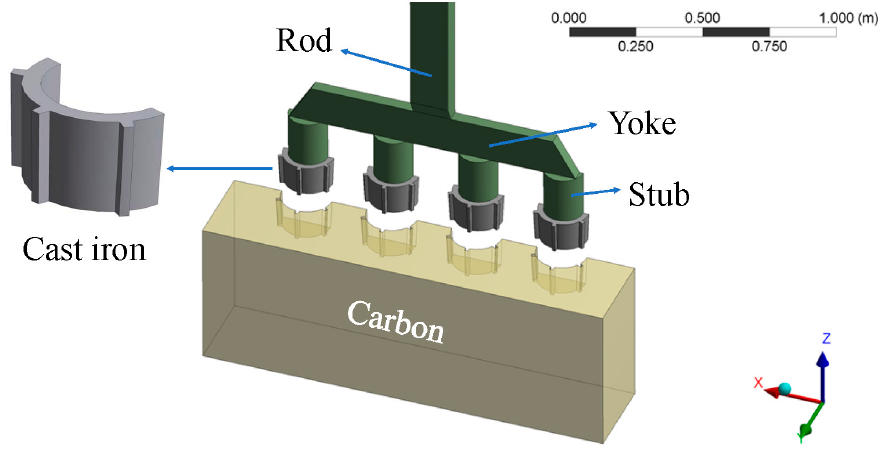
Figure 2. The geometry of the anode used in the present study.